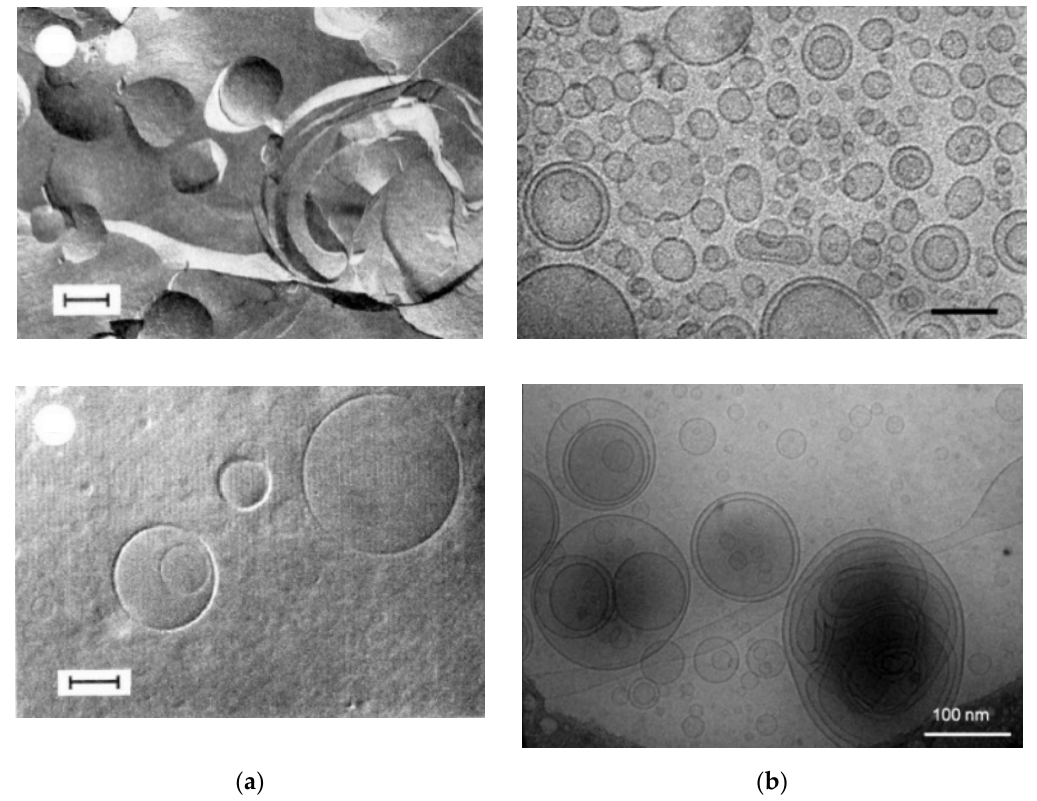
Figure 5. Electron and light microscopy visualizations of the formation of oleic acid vesicles in diulte aqueous media at T = 25 °C. ( a ) Freeze fracture electron microsopy image ( top , bar: 200 nm) and differential interference light microscopy image ( bottom , bar: 10 μ m) of spontaneously formed oleic acid vesicles at pH = 8.5 (prepared from oleic acid at 20 mM in 0.2 M Bicine buffer) [63]. ( b ) Cryo-TEM images of oleic acid vesicles prepared either at 5 wt% (=177 mM) oleic acid at pH = 8.0 (0.2 M Tris buffer using NaOH to adjust the pH value, followed by probe sonication) ( top , bar: 100 nm) [69], or from an oleic acid sample analyzed at pH = 8.6 (prepared from an acidic solution by addition of NaOH) ( bottom , bar: 100 nm) [68]. Critical vesiculation concentration, CVC (oleic acid + oleate, pH = 8.5–9.9) ~ 0.4–0.7 mM [63]. Reproduced with permission from [63], American Chemical Society, 1994; from [69], Elsevier, 2006; and from [68], American Chemical Society, 2010.